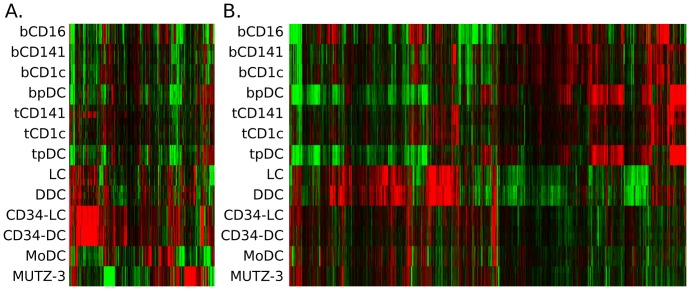
Heatmaps visualizing gene expression profiles of in vitro DC models and ex vivo DC populations.Hierarchical clustering on differentially expressed transcripts (ANOVA p<10−6, corresponding to p<0,05 upon Bonferroni correction) among in vitro DCs (A. 892 transcripts) and ex vivo DCs (B. 9,055 transcripts), using complete linkage and Euclidean measure. Colors represent high (red) and low (green) normalized intensity, respectively.